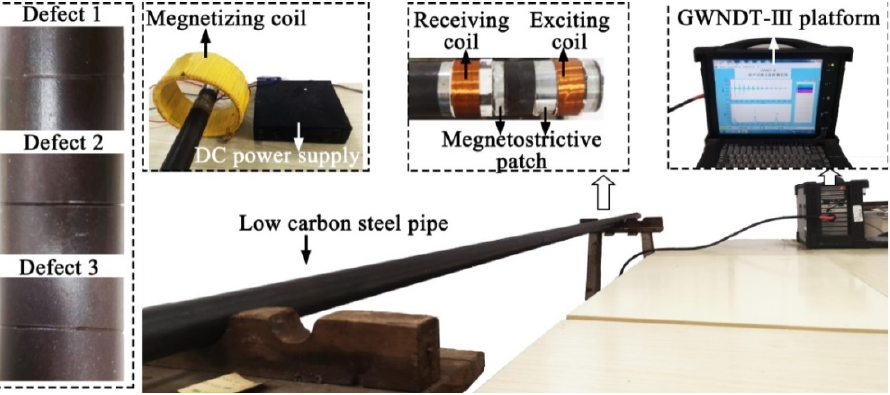
Figure 15. Schematic diagram of magnetostrictive UGW testing.